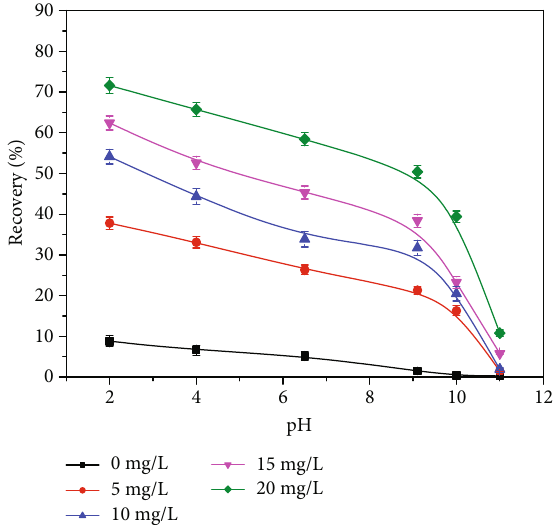
Figure 6: E ff ect of TO dosage on the recovery of